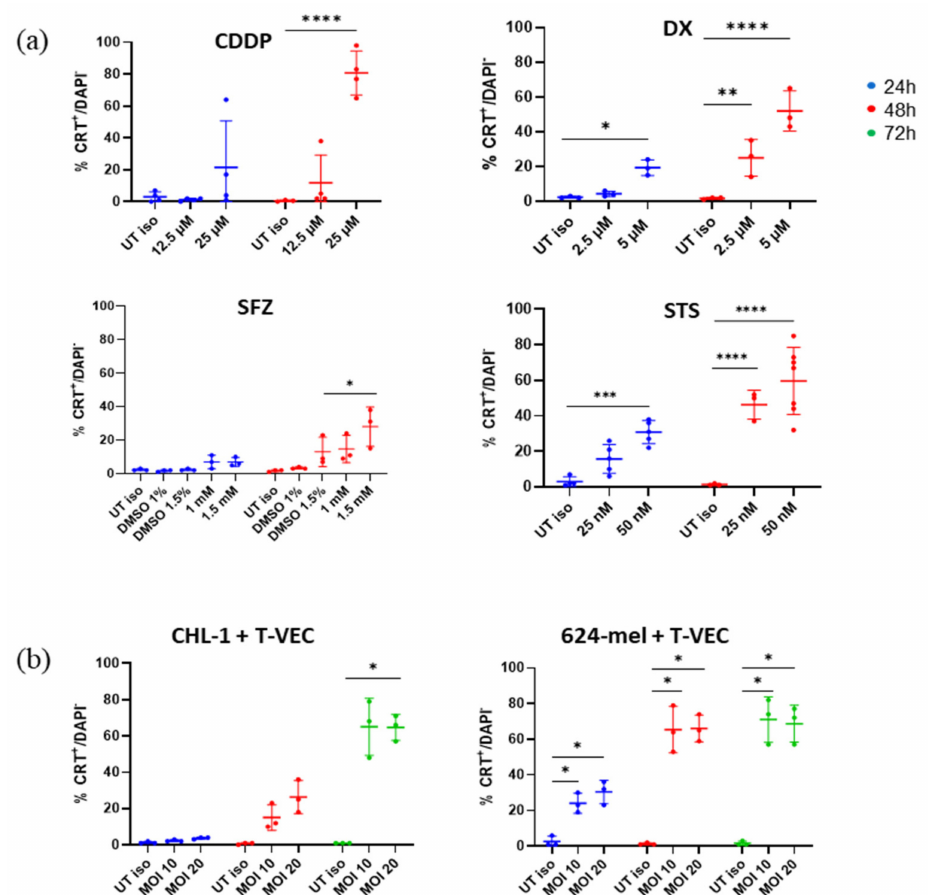
Figure 2. Exposure of surface CRT in response to various treatments. ( a ) CHL-1 cells were treated with CDDP, DX, STS or SFZ for up to 48 h. Within the DAPI negative population surface CRT was detected by means of flow cytometry. CRT levels were compared to untreated, isotype-stained cells. ( b ) CHL-1 or 624-mel cells were treated with T-VEC for up to 72 h. Within the DAPI negative population surface CRT was detected by means of flow cytometry. Data display at least three repeats of independent experiments. Data were analyzed with two-way ANOVA or mixed model with Šid á k corrections. * p < 0.05; ** p < 0.01, *** p < 0.001 and **** p < 0.0001 Abbreviations: